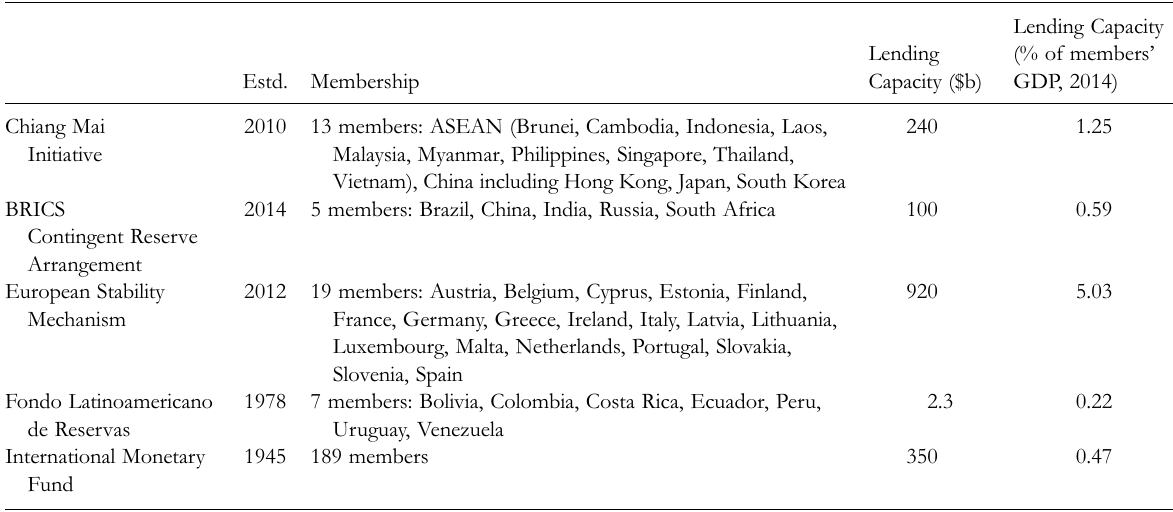
Table 1: Key Characteristics of Regional Financial Arrangements (relative to the IMF)